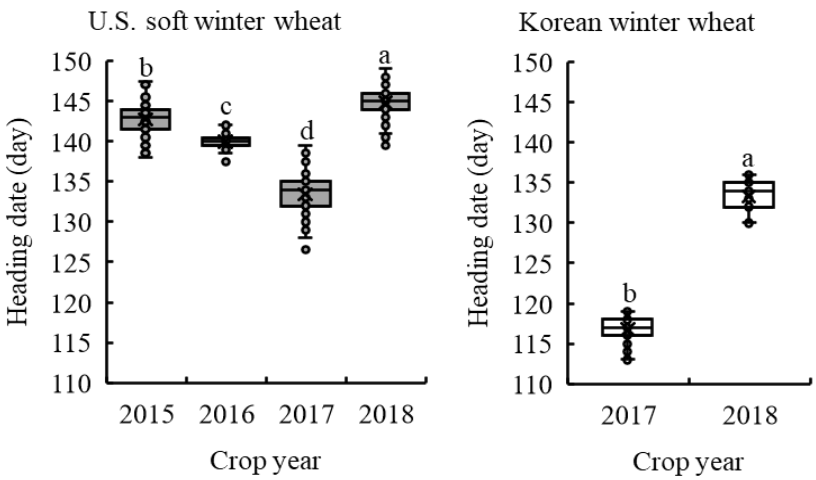
Figure 1. Mean heading dates of 121 eastern U.S. soft winter wheat genotypes grown in 2015–2018 and 32 Korean winter wheat varieties grown in 2017 and 2018 in Wooster, Ohio. x indicates the mean. Means with different letters are significantly different at p < 0.05.